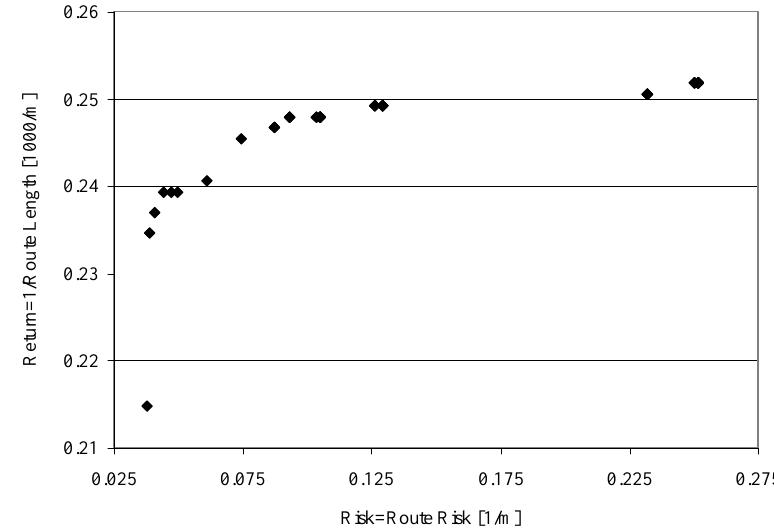
Figure 9: Efficient frontier for the minefield in Figure 6.